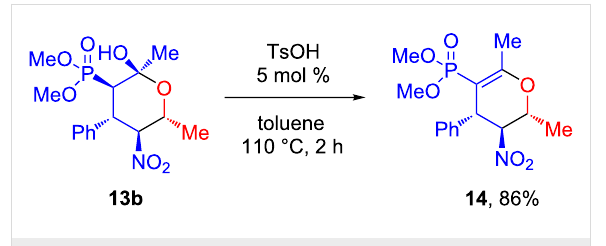
All hydrogen atoms and the hydroxy group occupy an axial po- sition, while the remaining substituents are in equatorial posi- tions. This is consistent with the 1 H NMR data for other similar tetrahydropyranols 13b – f , therefore, their configuration was assumed by